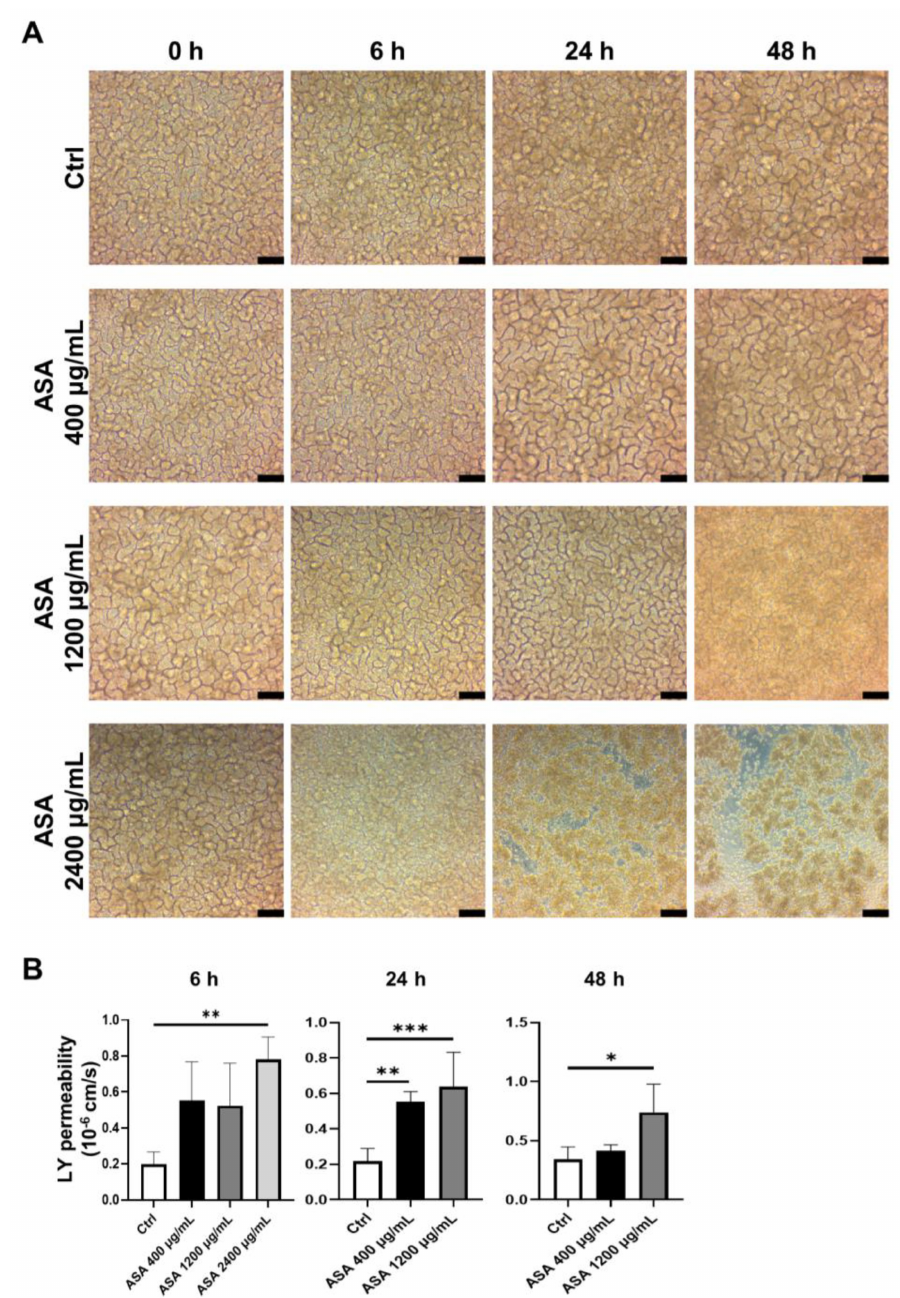
Figure 2. Acetylsalicylic acid (ASA) induced small intestinal injury in 2D-iPSC-SI. ( A ) Time-course analysis of cultured 2D-iPSC-SI under different ASA concentrations. The extent of damage increased in an ASA concentration-dependent manner. ( B ) Relative LY permeability indicated increased small intestinal permeability after ASA incubation. LY permeability increased significantly at 6 h in the ASA 2400 µ g/mL group compared with the control group (ASA 2400 µ g/mL vs. control, p < 0.01). At 24 h, LY permeability was significantly higher in the ASA 400 µ g/mL and ASA 1200 µ g/mL groups than control group ( p < 0.01 and p < 0.001, respectively). At 48 h, LY permeability was significantly higher in the ASA 1200 µ g/mL group than control group ( p < 0.05); mean ± SD; n = 3–5. Statistical analysis was performed using two-tailed Dunnett’s test; * p < 0.05, ** p < 0.01, *** p < 0.001. ASA: acetylsalicylic acid, Ctrl: control, LY: Lucifer